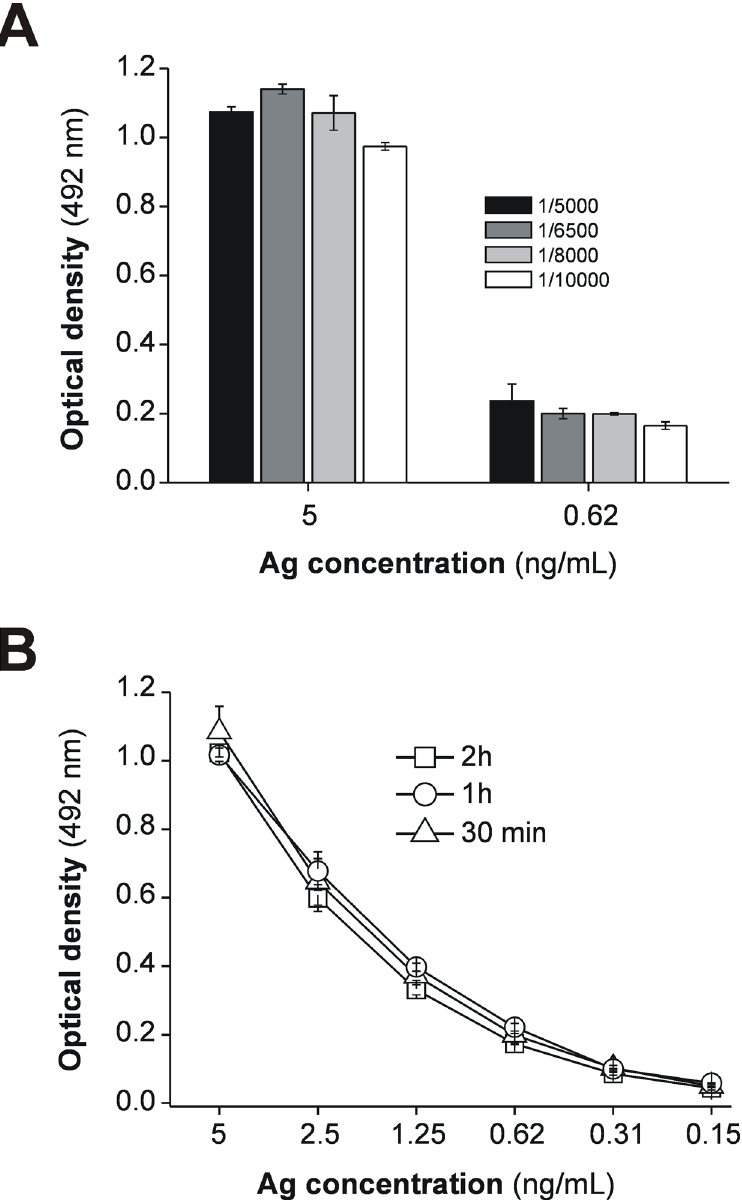
Fig 1. Adaptation of the SA-PolyHRP conjugate and rapid incubations to the MM3-COPRO ELISA. (A) Two concentrations (5 and 0.62 ng/mL) of whole Fasciola hepatica excretory-secretory antigens (Ag) diluted in CoproGuard were tested with the MM3-COPRO ELISA by using several dilutions of SA-PolyHRP (ranging from 1/10,000 to 1/5,000) as secondary reagent to reveal bound biotinylated mAb MM3. All incubation steps were performed at RT for 30 min with shaking (750 rpm). (B) Two-fold dilutions (0.15 – 5 ng/mL) of Ag diluted in CoproGuard were assayed with the MM3-COPRO ELISA (SA-PolyHRP diluted 1/8,000) at RT with shaking for several incubation times (30 min, 1 h and 2